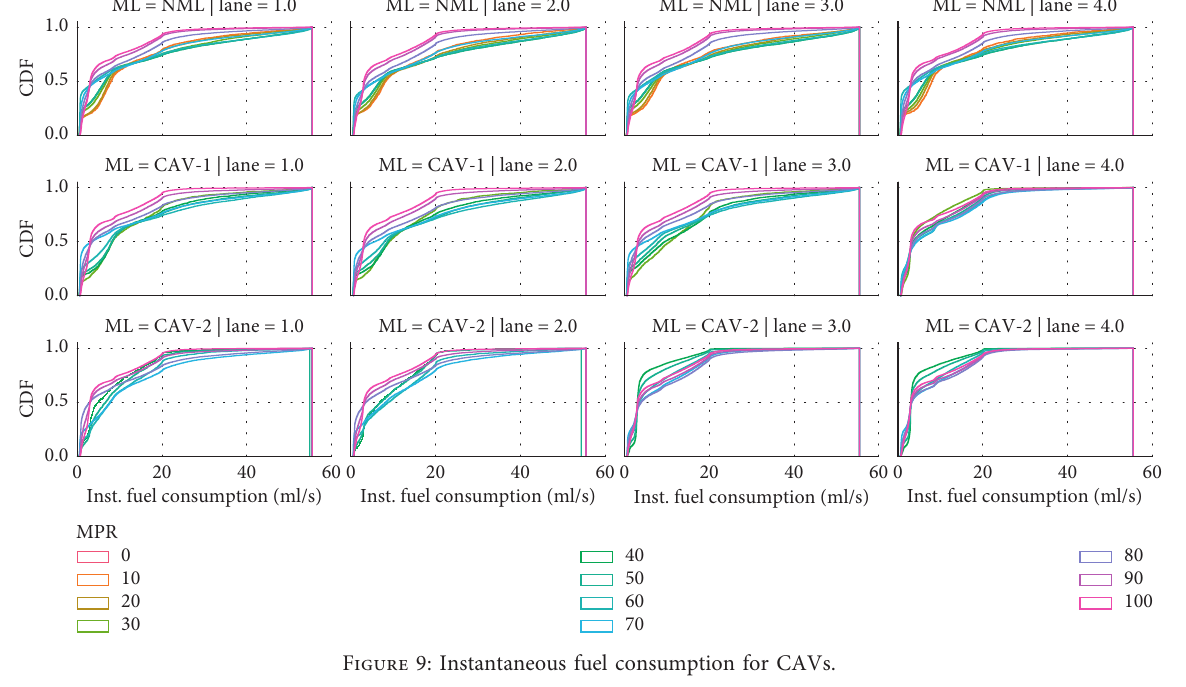
Figure 9: Instantaneous fuel consumption for CAVs.